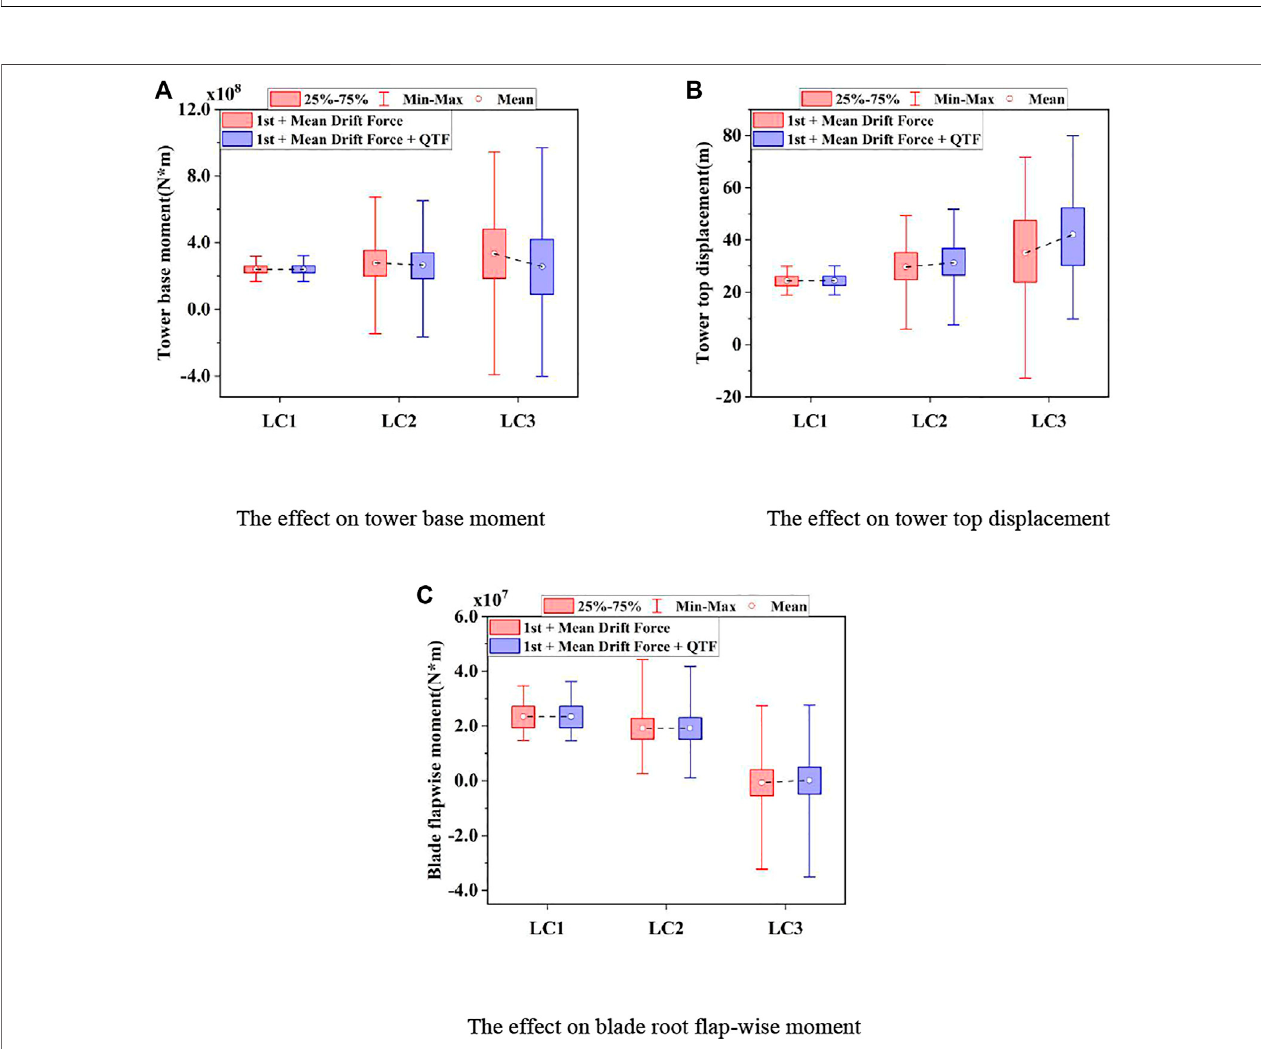
FIGURE 9 | Statistical results of the effect of the difference-frequency QTF on the structural dynamic response. (A) Effect on tower base moment. (B) Effect on tower top displacement. (C) Effect on blade root fl apwise moment.